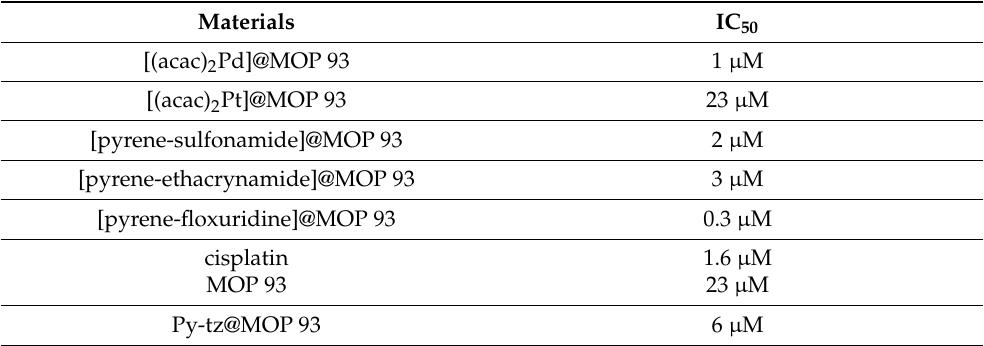
Table 3. Describing the cytotoxicities of cisplatin, MOP 93 and guest encapsulated MOP